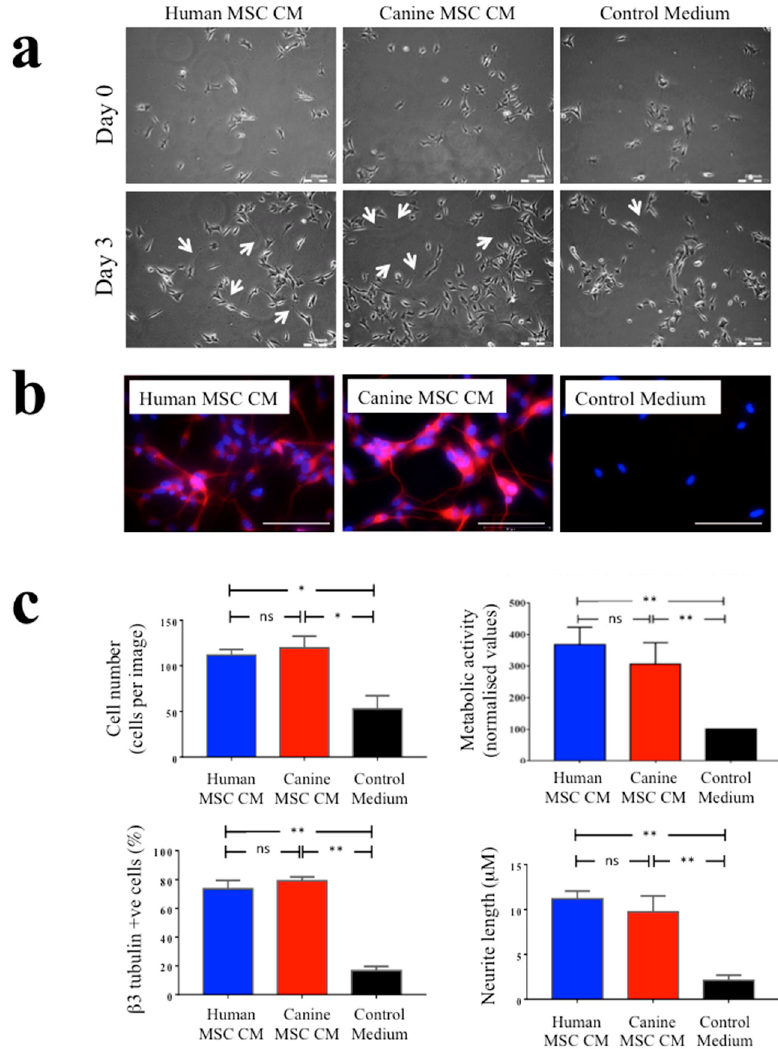
Figure 2. Human and canine MSC conditioned medium increased SH-SY5Y cell proliferation, β III tubulin immunopositivity and neurite outgrowth to a similar extent. ( a ) Representative images are shown of SH-SY5Y neuronal cells under phase-contrast microscopy following culture for three days in human MSC conditioned medium (human MSC CM), canine MSC conditioned medium (canine MSC CM), or control medium. As shown, there was enhanced cell numbers and neurite outgrowth (arrowed) in both human and canine MSC CM compared with control cultures. Scale bars = 200 µ m. ( b ) Representative fluorescence images of SH-SY5Y cells after three days of culture in human MSC CM, canine MSC CM or control medium following immunocytochemical staining for the neuronal marker, β III tubulin. As shown, β III tubulin immunopositive cells were seen in human and canine MSC CM to a much greater extent than in control conditions. ( c ) (top panels) Image analysis software demonstrated significantly increased SH-SY5Y cell numbers in the presence of human and canine MSC CM compared to control medium after three days in culture (top left) as well as increased metabolic activity as determined by MTT assays (top right); (bottom panels) there were significant increases the proportions of β III tubulin immunopositive cells in human and canine MSC CM compared to the control medium, as well as increased neurite length. * p ≤ 0.05, ** p ≤ 0.01, ns = nonsignificant. Data shown as means ± SEM, with a minimum of three independent